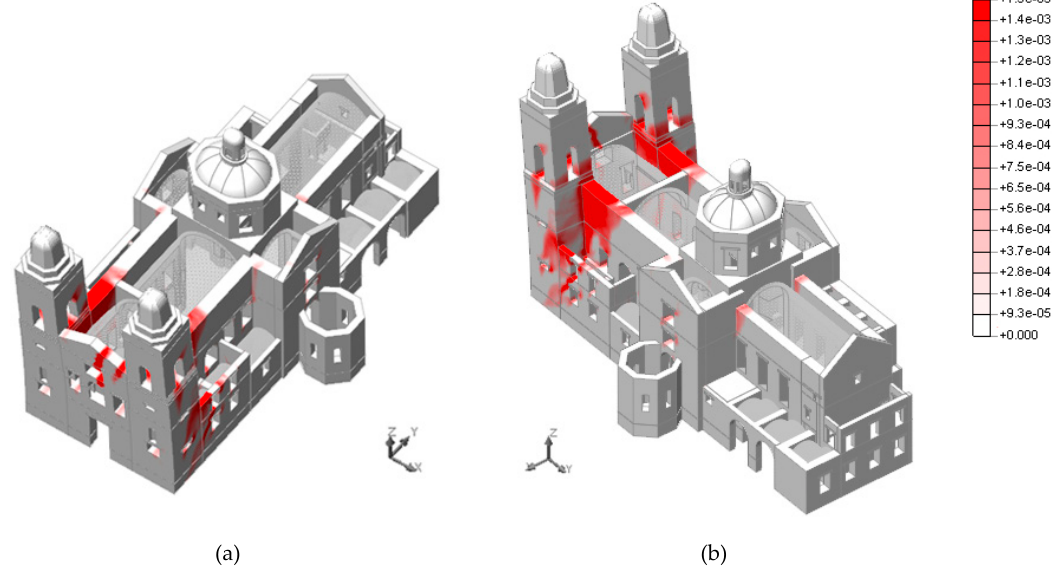
Figure 13. Crack width associated with the maximum principal strain at the end of the capacity curve for the pushover analysis in the negative longitudinal direction (–YY). ( a ) South-West view; ( b ) South-East view. Units in m.